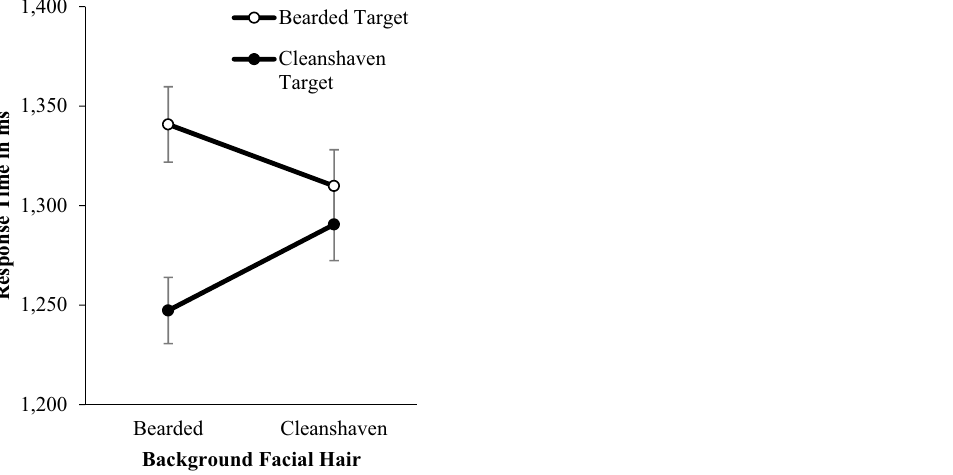
Figure 8. Mean response times in milliseconds (± 1 SEM) for Study 3 indicating the presence or absence of emotional bearded or clean-shaven targets in bearded or clean-shaven